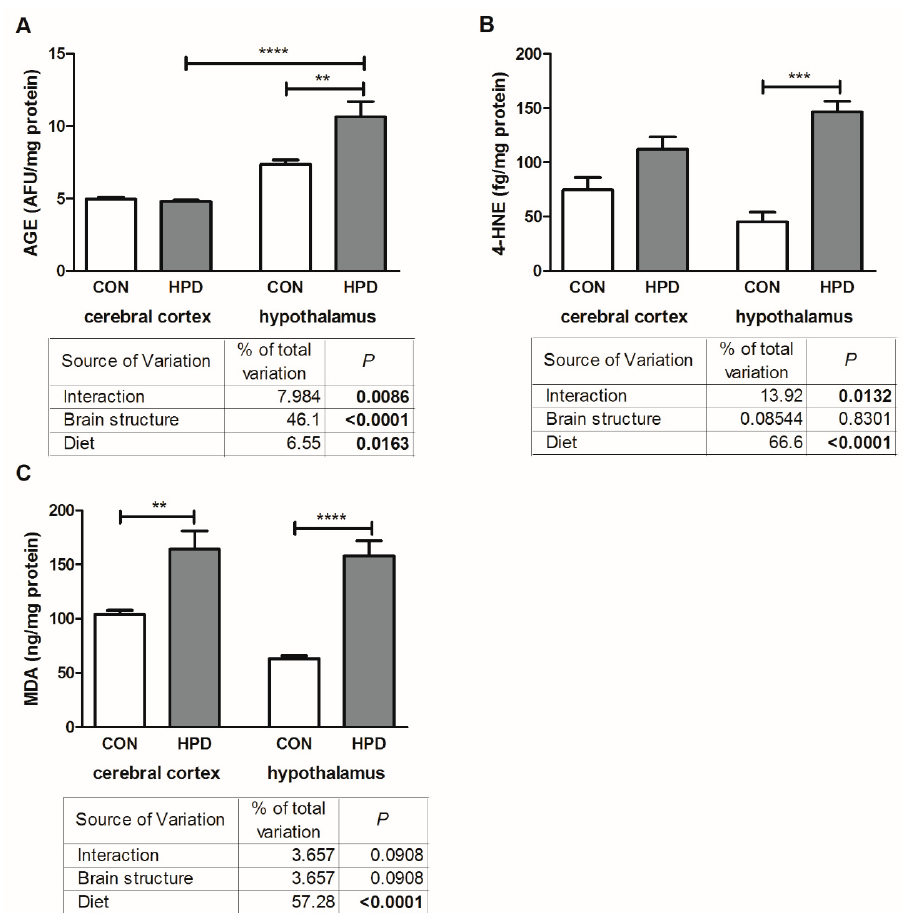
Figure 5. Effect of 8-week HPD on oxidative damage products (advanced glycation end products ( A ), 4-hydroxynonenal ( B ), malondialdehyde ( C )) in rat cerebral cortex and hypothalamus. Values are means ± SEMs, n = 9. Differences statistically significant at: ** p < 0.005, *** p < 0.0005, **** p < 0.0001. 4-HNE, 4-hydroxynonenal; AGE, advanced glycation end products; CON, standard diet; HPD, high protein diet; MDA, malondialdehyde.